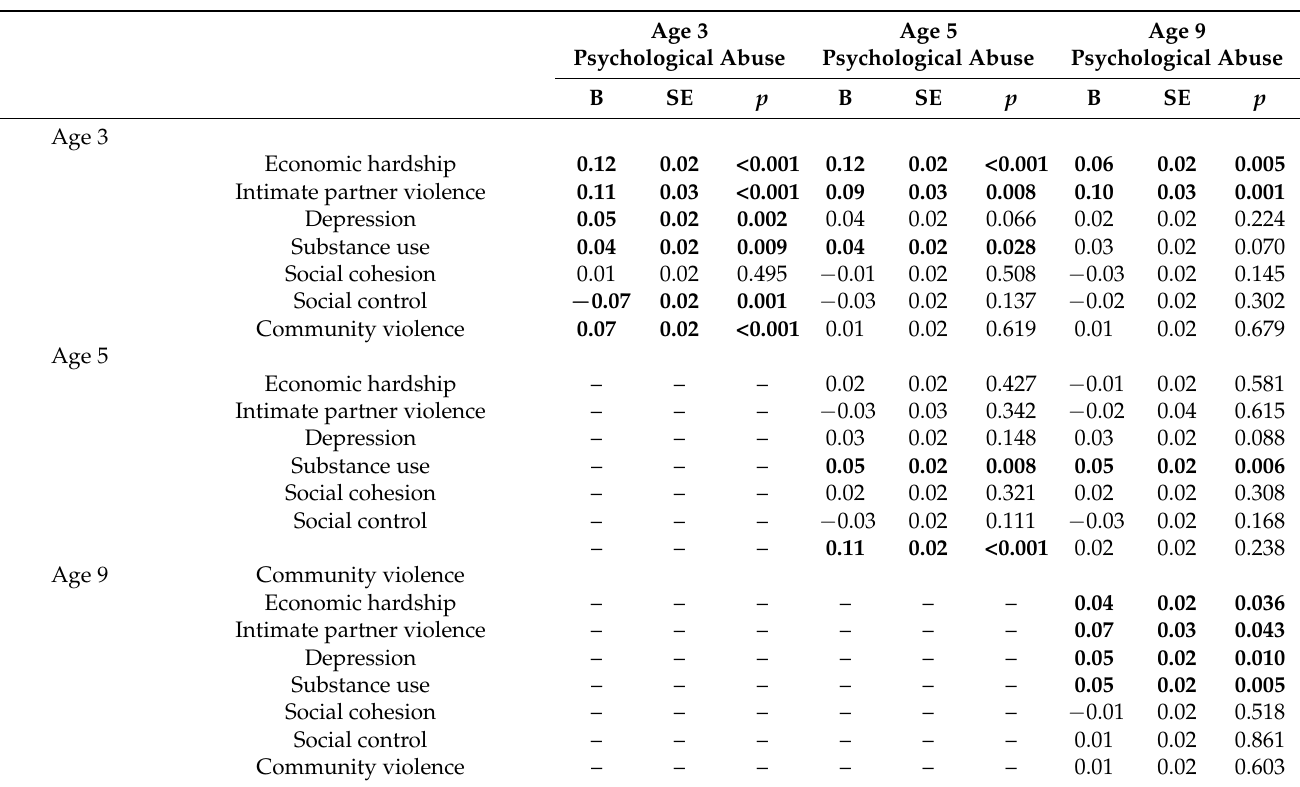
Table 3. Time-varying predictors of psychological